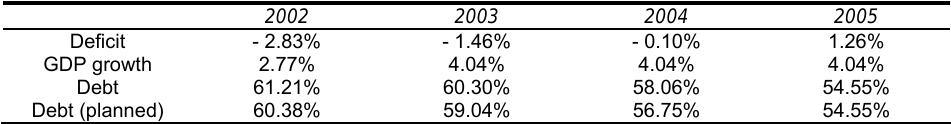
Table 5. German government deficit plan after a one-time deviation and revision in